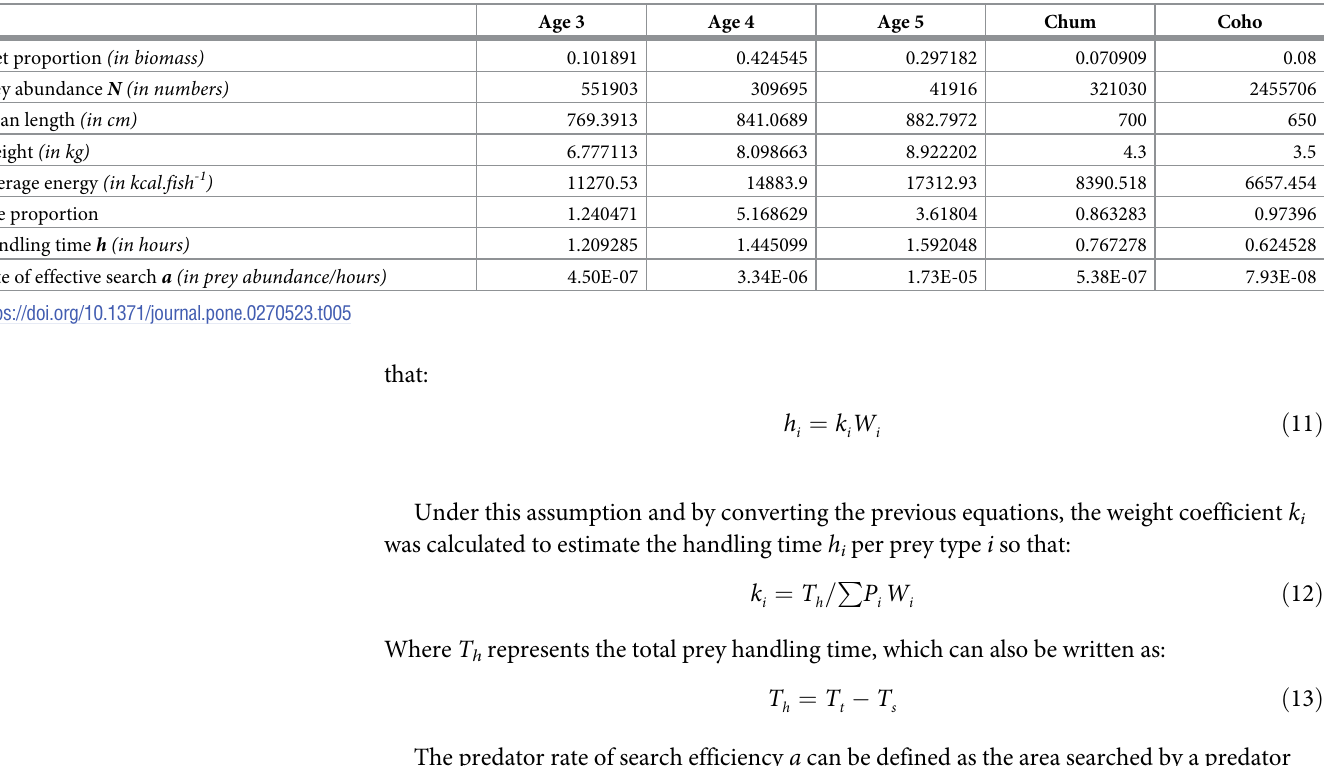
Table 5. Base parameters used to calibrate the Holling disc equation.